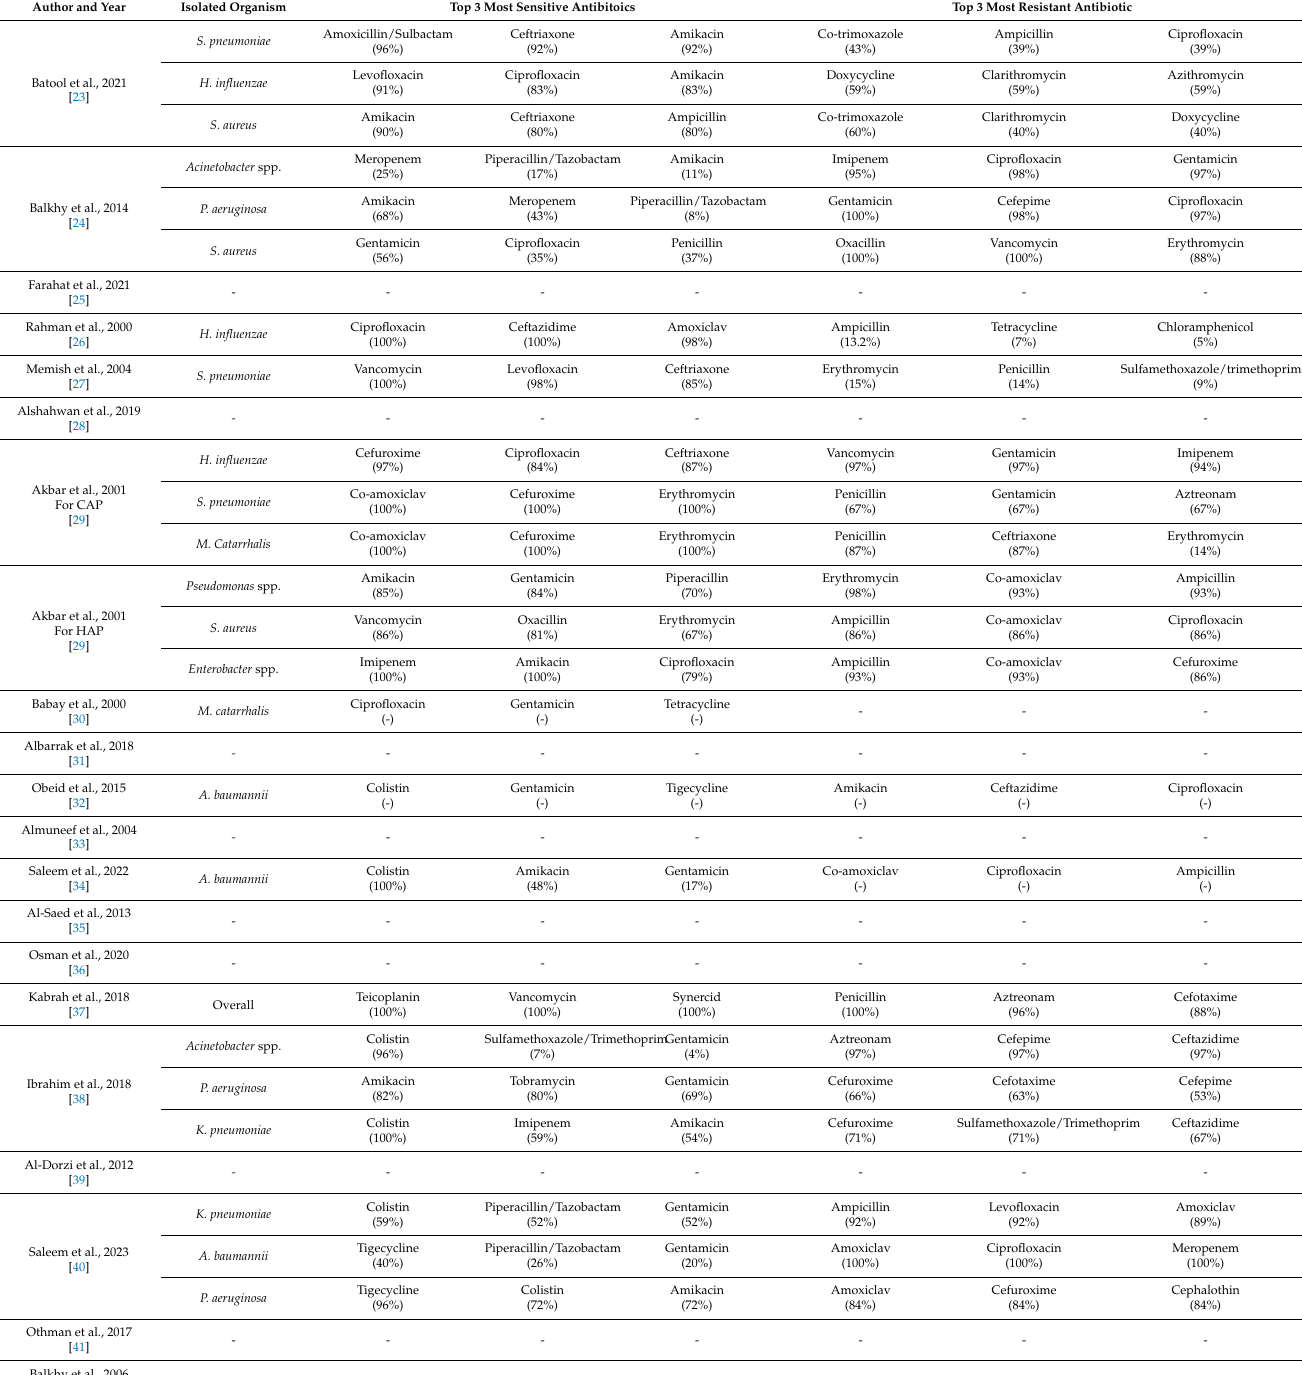
Table 2. Susceptibility and resistance patterns of